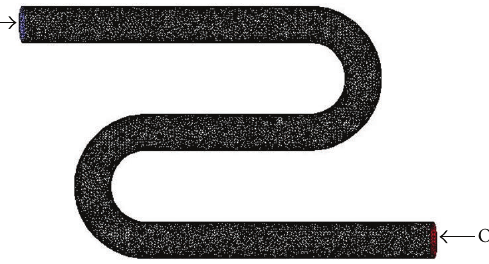
Figure 2: Meshed geometry with flow direction.